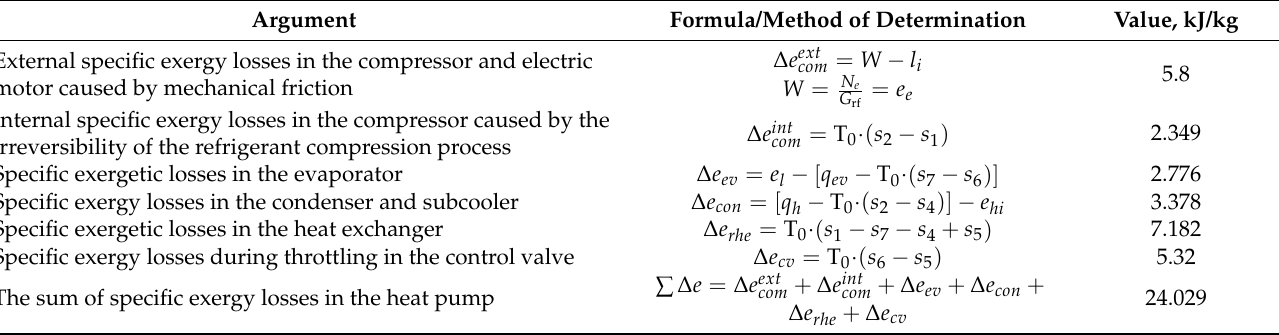
Table 4. Exergy balance of the heat pump